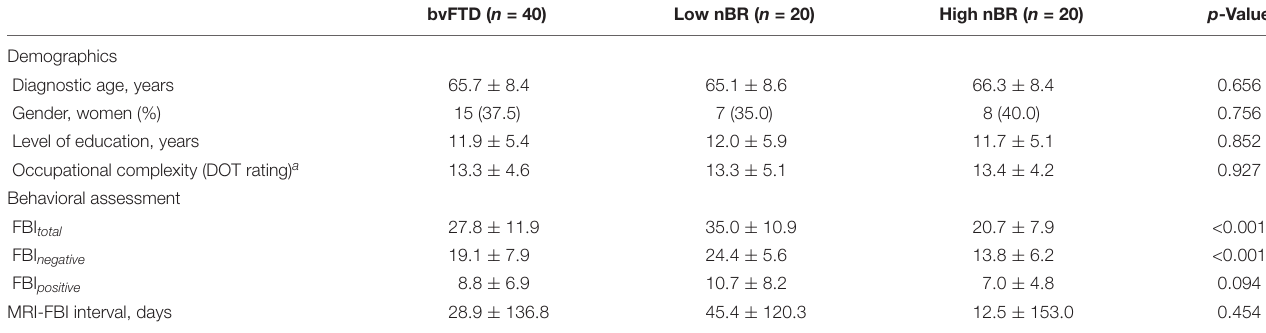
TABLE 1 | Demographic characteristics and behavioral assessment of the participants with bvFTD classified into the low behavioral reserve for negative symptoms (nBR) group and the high nBR group. bvFTD ( n =